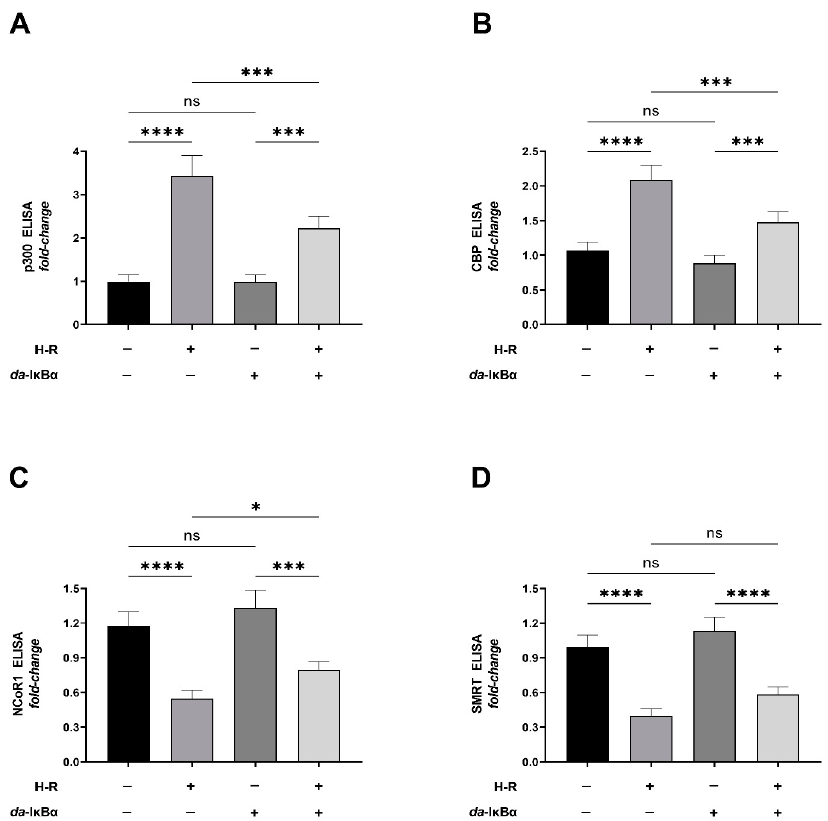
Figure 3. Hypoxia–reoxygenation (H-R) challenge increases the abundance of miR-210 promoter- bound transcriptional coactivators, p300 and CBP, concomitant with a decrease in abundance of the miR-210 promoter-bound transcriptional corepressors, NCoR1 and SMRT, through NF- κ B activation. ( A – D ) Quantitative ELISA determining the relative abundance of p300 ( A ), CBP ( B ), NCoR1 ( C ), and SMRT ( D ) in the lysates emanating from the reverse crosslinked miR-210 promoter pull-down fragments from H-R challenge-subjected cells ectopically expressing the da -I κ B α mutant. The relative abundance of β -actin (Supplementary Figure S4A) and chromatin-associated TBP (Supplementary Figure S4B) in the native cellular lysates was determined using sandwich ELISA immunoassays to validate equitable inputs across the experimental lysates subjected to miR-210 promoter pull-down . The relative abundance of chromatin-associated histone H3 (Supplementary Figure S4C) was determined in the reverse crosslinked miR-210 promoter pull-down fragment to validate that equitable fraction of the miR-210 promoter was pull-down across the experimental lysates. The ec- topic expression of the HA-tagged da- I κ B α mutant was validated using sandwich ELISA immuno- assay performed against the HA tag (Supplementary Figure S4D). NF- κ B transcriptional activity (Supplementary Figure S4D, bo tt om panel) was determined in the native lysates to corroborate and validate the translative e ff ects of the ectopic expression of the da- I κ B α mutant. Data are expressed as experimental blank-corrected absorbances (O.D) measured at λ 450 (450 nm) normalized to fold change values. All data are expressed as mean fold change ± S.D. values from three technical replicates for each of the four biological replicates belonging to each experimental group ( n = 4). * p ≤ 0.05; *** p ≤ 0.001; **** p ≤ 0.0001; ns: not signi fi cant ( p > 0.05). S.D.: standard deviation.